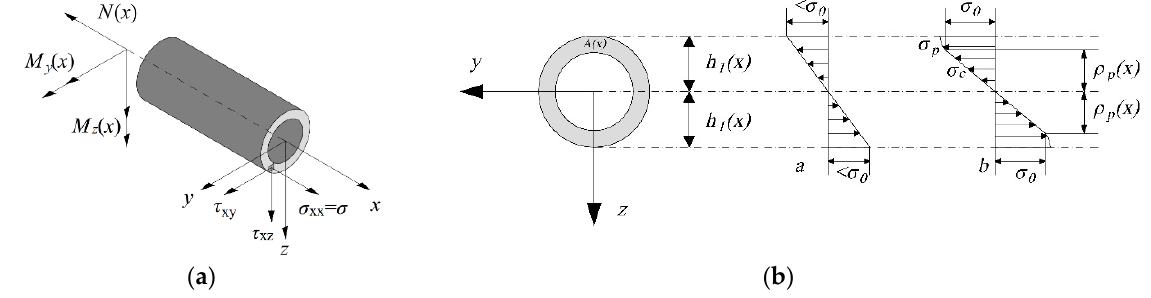
Figure 1. Elastic and elastic–plastic stress distribution in a circular steel tube bending problem. ( a ): A straight circular steel tube subjected to the bending moment My(x), Mz(x), and uniaxial force N(x). ( b ): The stress distribution along the y and z directions.